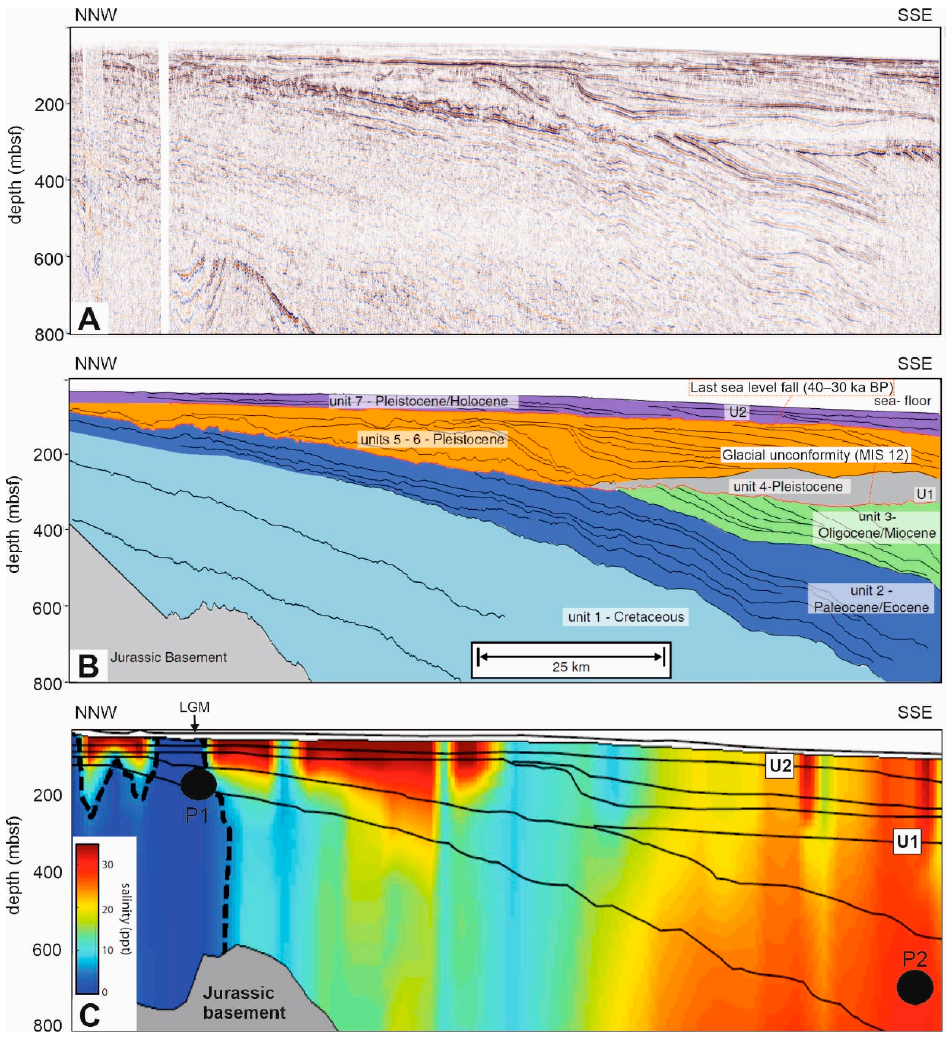
Figure 8. ( A ) Uninterpreted and ( B ) Interpreted seismic line showing age of units offshore Martha’s Vineyard (modified from Reference [117]). For the lithology, Unit 1: Carbonate sandstones; Unit 2: Carbonate mud; Unit 3: Silt/Clay clinoforms; Unit 4: Glacigenic sediments; Unit 5: Thin clay layer; Unit 6: Sand, silt, clay clinoforms; Unit 7: Glacial outwash. Location of line in Figure 6A. ( C ) Predicted, present-day salinity for base-case model with ice advance during Marine Oxygen Isotope Stage (MIS) 12 followed by four additional ice advances to the margin of the LGM. Dashed black lines are 5 ppt salinity contour. Thin black lines mark model unit boundaries (simplified stratigraphy used as model input). Arrows indicate the maximum extent of the LGM ice sheets. The maximum extent of the MIS 12 ice sheet is located outside the figure boundaries, further to the SSE. The black dots (P1 and P2) mark the locations where salinity and hydraulic head are modelled through time (see model in the original paper) (modified from [117]).